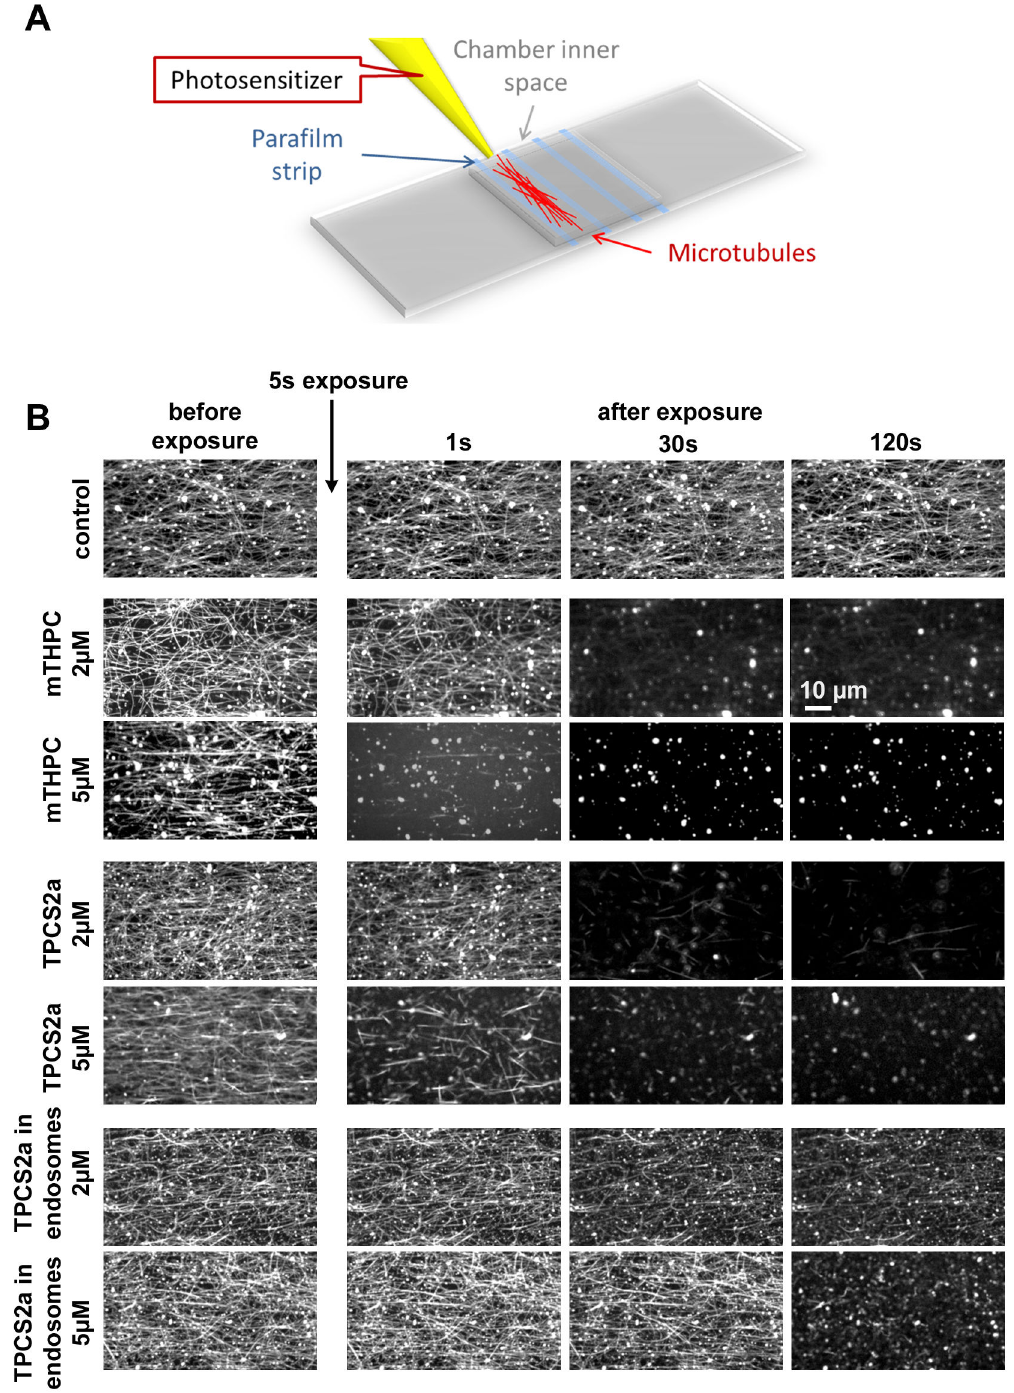
Figure 6. Monitoring microtubule depolymerization. (A) Schematic representation of the cover glass chamber used in the in vitro microtubule assay featuring an inner space filled by capillarity. (B) Network of reconstituted microtubules immersed in a bath containing a photosensitizer. With m-THPC or TPCS2a at a concentration of 2 or 5 µM in solution, complete depolymerization occurred very rapidly, within less than 10 seconds. We can see first the destabilization (1s) of the microtubule structure and second the depolymerization. When TPCS2a-labelled endosomes are used as photodynamic agent, at the same concentration, the depolymerization is strongly delayed.